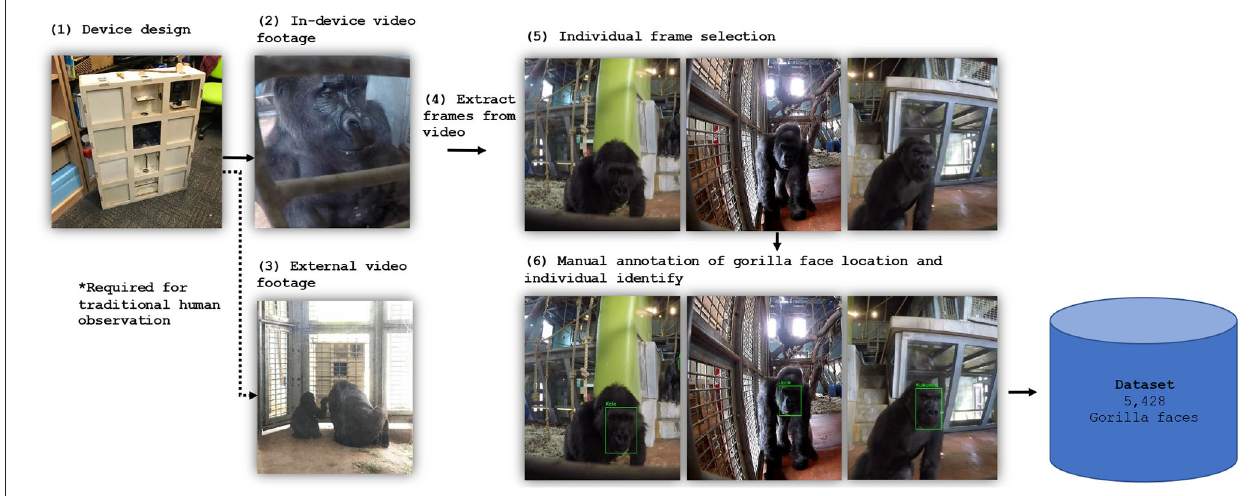
FIGURE 2 | Dataset generation. Cameras recorded front-facial footage of the gorillas (2). Individual frames were extracted from the video footage (4), assessed for suitability and selected for labeling (5). This resulted in 5,248 individual frames being manually annotated with bounding box and identity information (6). Note that (3) forms part of the human observation